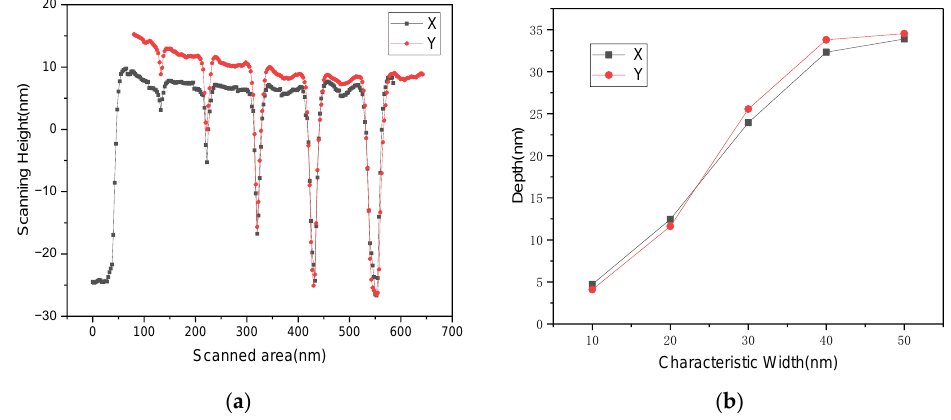
Figure 11. ( a ) Scanning AFM image profile of grooves part in tip characterizer; ( b ) Information cor- responding to the depth and width of the tip.